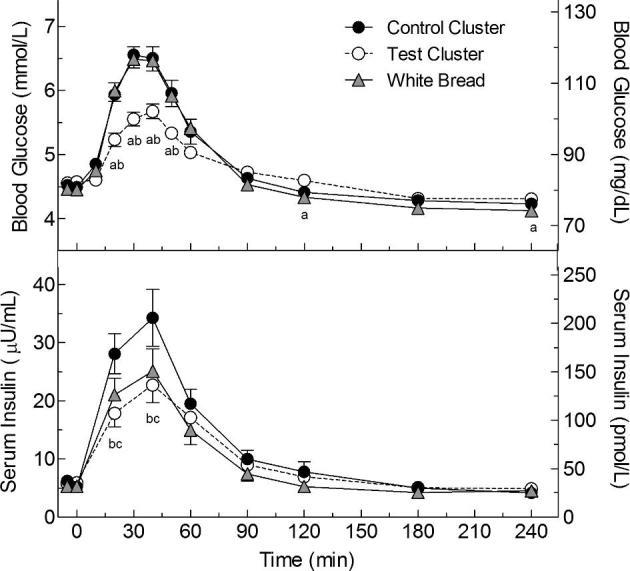
Glucose and insulin responses after the different meals. Points are means ± SEs for n = 25 subjects. aSignificant difference between test-cluster and white bread (P < 0.05 by Tukey's test). bSignificant difference between test-cluster and control-cluster (P < 0.05 by Tukey's test). cSignificant difference between control-cluster and white bread (P < 0.05 by Tukey's test).